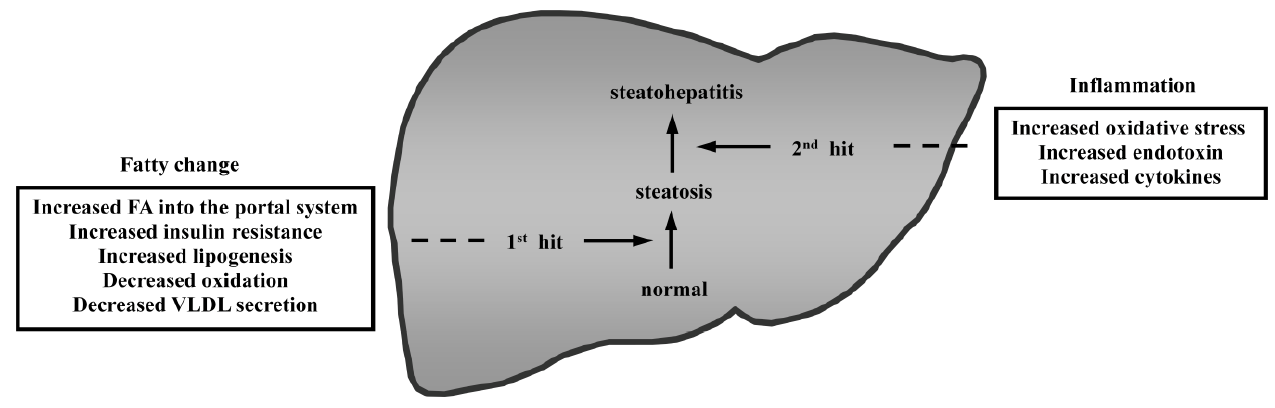
Figure 1. The “two-hit” theory for the pathogenesis of nonalcoholic fatty liver disease and nonalcoholic steatohepatitis. Hepatic steatosis is the initial step that occurs commonly. Then, the liver progresses from steatosis to steatohepatitis through the action of a second step. The progression from normal liver to steatohepatitis is a multistep process involving the development of fatty changes and hepatic